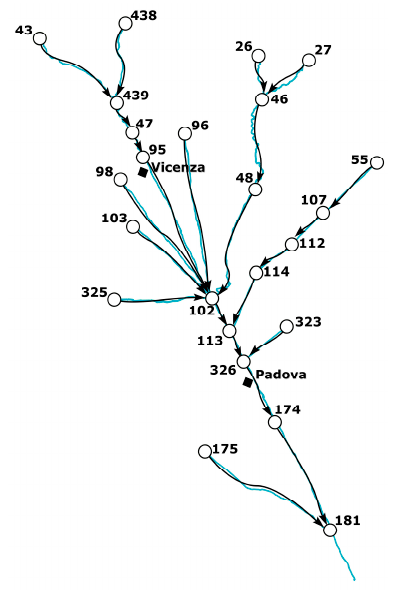
Figure 4. Graphical representation of the river Bacchiglione.